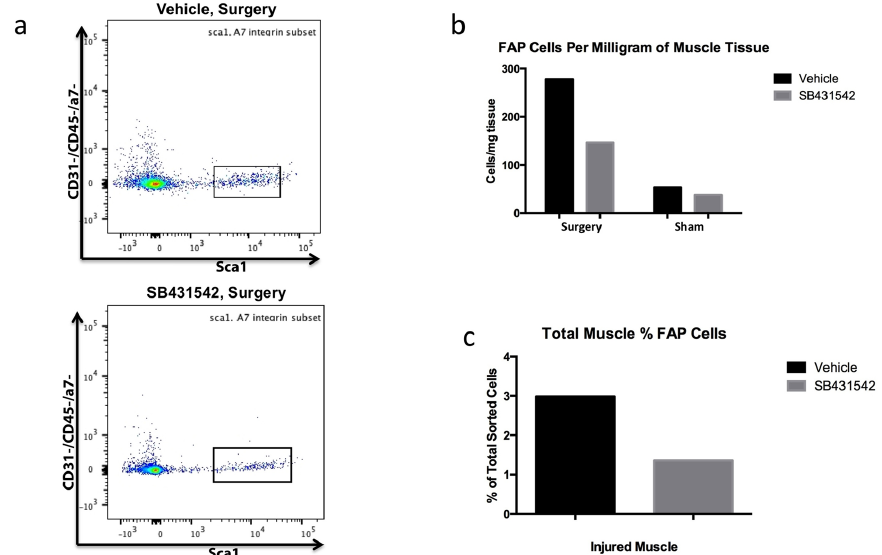
Fig 6. SB431542 decreases CD31-/CD45-/a7-/sca1+ FAP cell number at 2 weeks. (a) Representative flow cytometry overlay plots of cells sorted from vehicle group (upper plot) and SB431542 treatment group (lower plot); N = 8 supraspinatus, 8 infraspinatus pooled per group. Gate indicates sca1+, a7 integrin- FAP cells out of the CD31-/CD45- population. (b) Quantification of total CD31-/CD45-/a7-/sca1+ cell number per mg of sorted tissue. (c) Percent CD31-/CD45-/a7-/sca1+ cells of total cells sorted in injured muscle